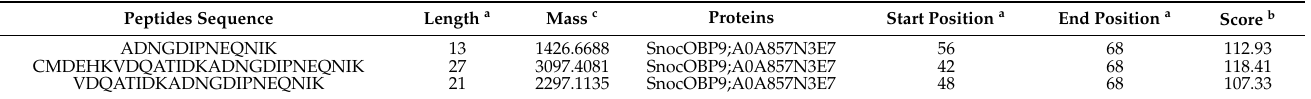
Table 1. The LC-MS/MS analysis of SnocOBP9. Table 2. The LC-MS/MS analysis of the three peptides in SnocOBP9. Peptides